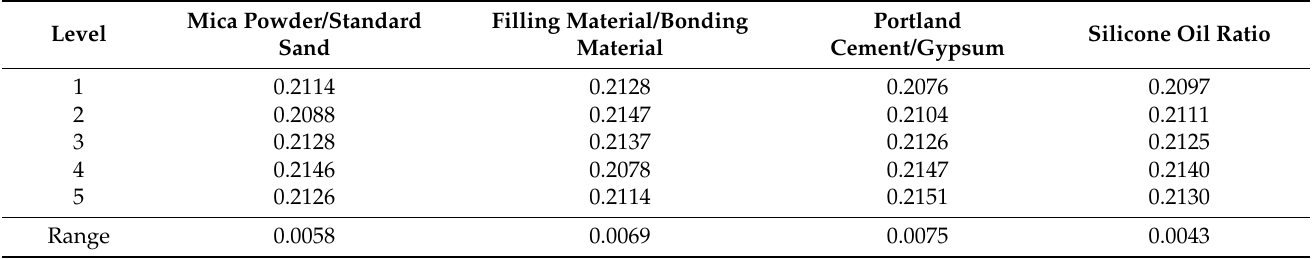
Table 13. Range analysis of Poisson’s ratio.